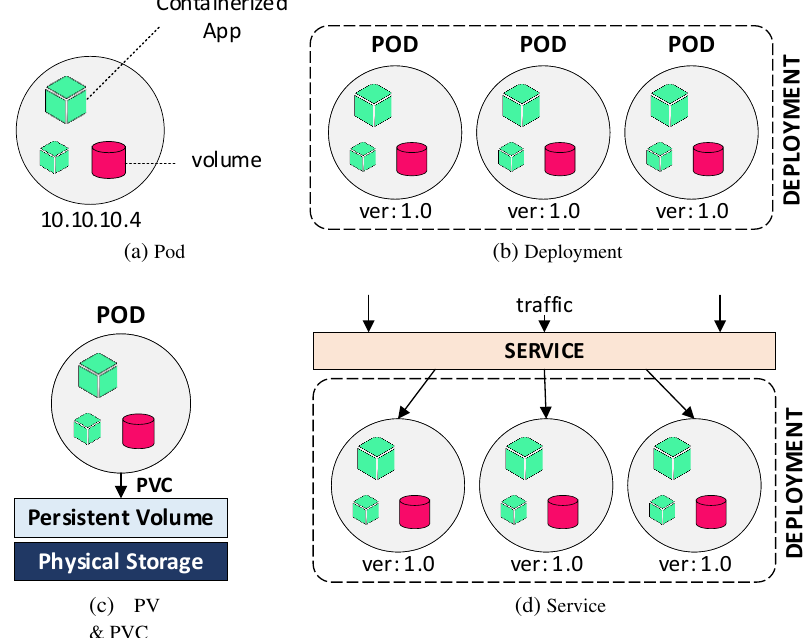
Fig. 1. Kubernetes core deployment